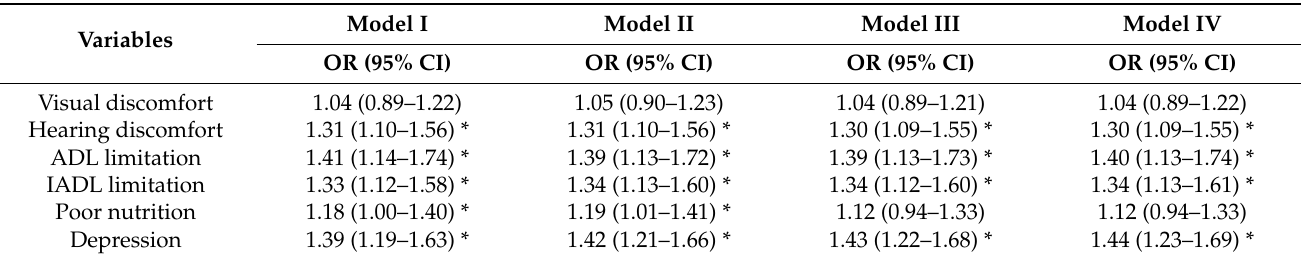
Table 3. Multivariable logistic regression analysis of factors associated with fall incidents in older adults with negative subjective health